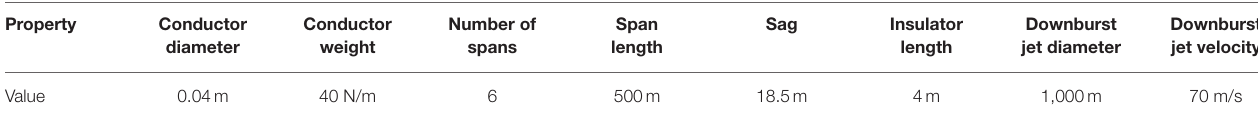
TABLE 1 | Properties of the conductor system and the downburst. Property